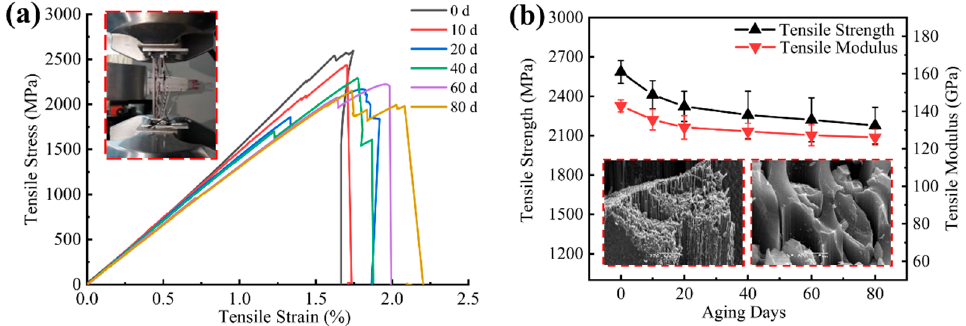
Figure 13. ( a ) Longitudinal direction tensile stress-strain curve; ( b ) longitudinal tensile strength/modulus versus aging time.